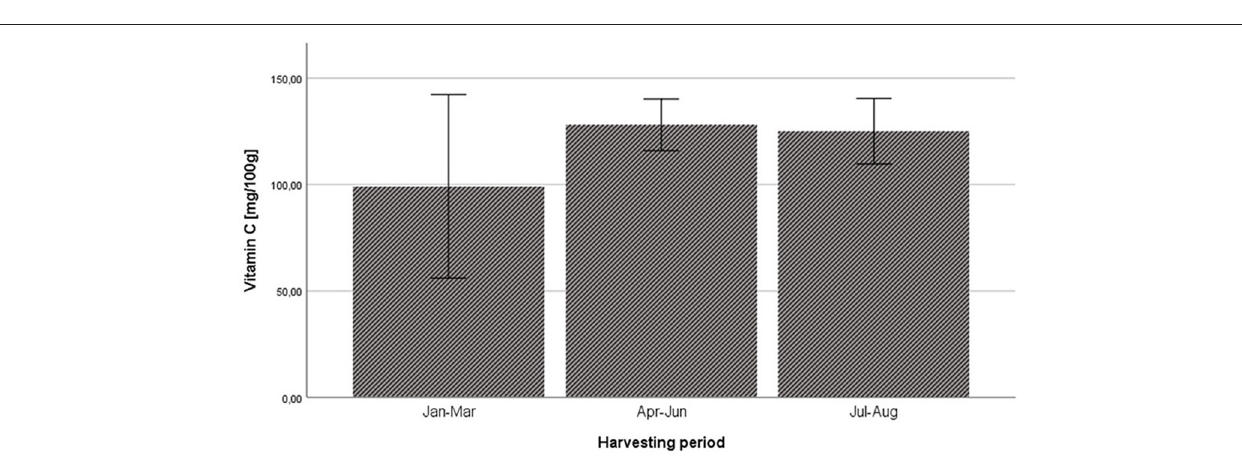
FIGURE 6 | Vitamin C content by fruit harvesting period (error bars: 95%